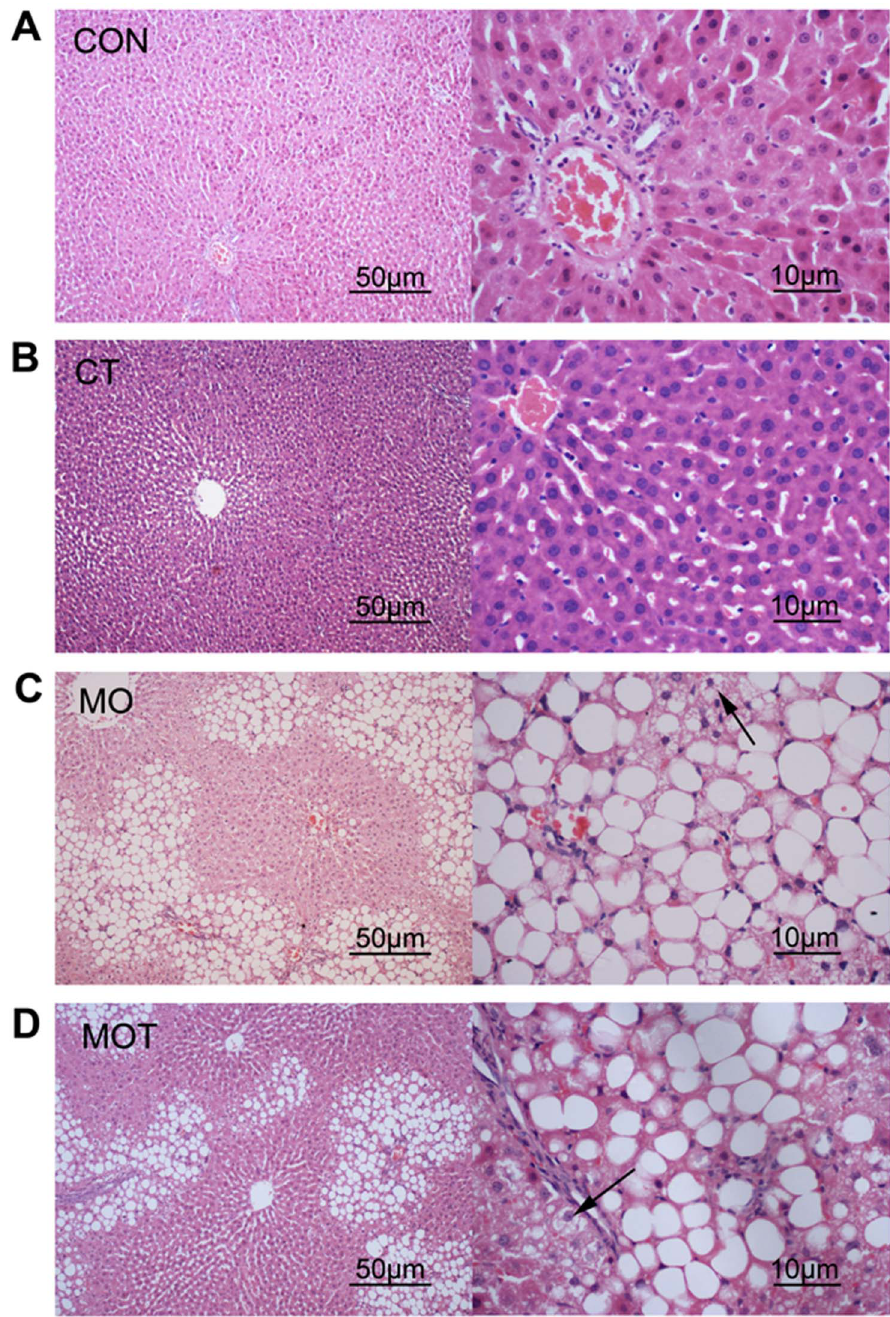
Figure 3. Maternal liver histology. Left column, H&E, 10 6 magnification; right column 40 6 magnification. CON: control, n=9; CT: control with taurine, n=7; MO: maternal obesogenic diet, n=8; MOT: MO maternal obesogenic diet with taurine, n=7. Arrows indicate ballooned